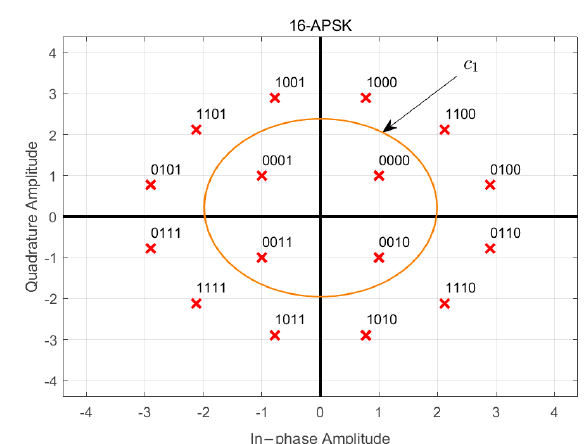
Figure 2. Diagrammatic sketch of ring judgment for 16APSK signals.